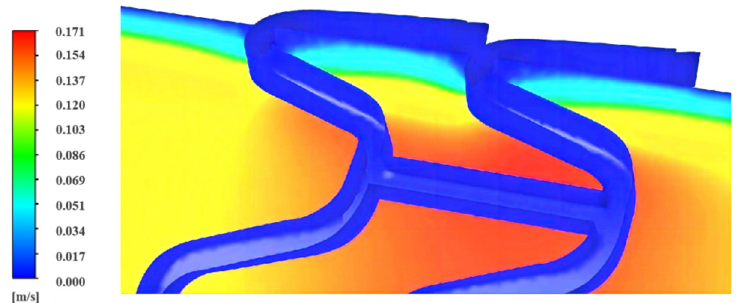
Figure 15. Intravascular flow field after coronary artery stent deployment.